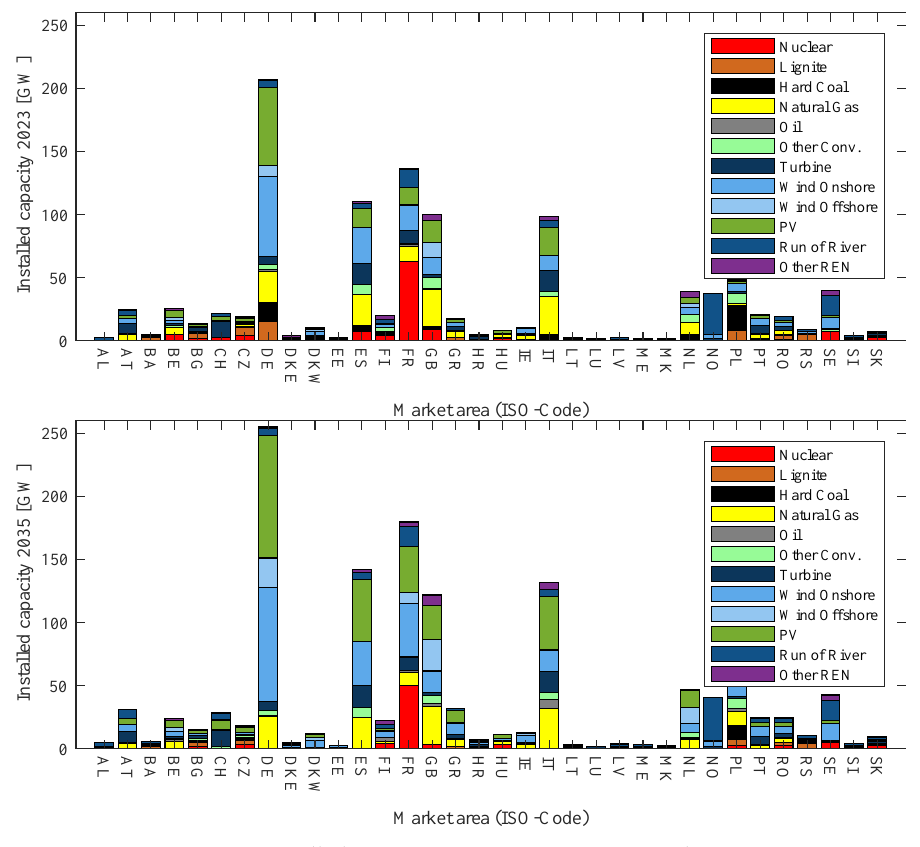
Figure 8. Installed capacities per country in 2023 and 2035.